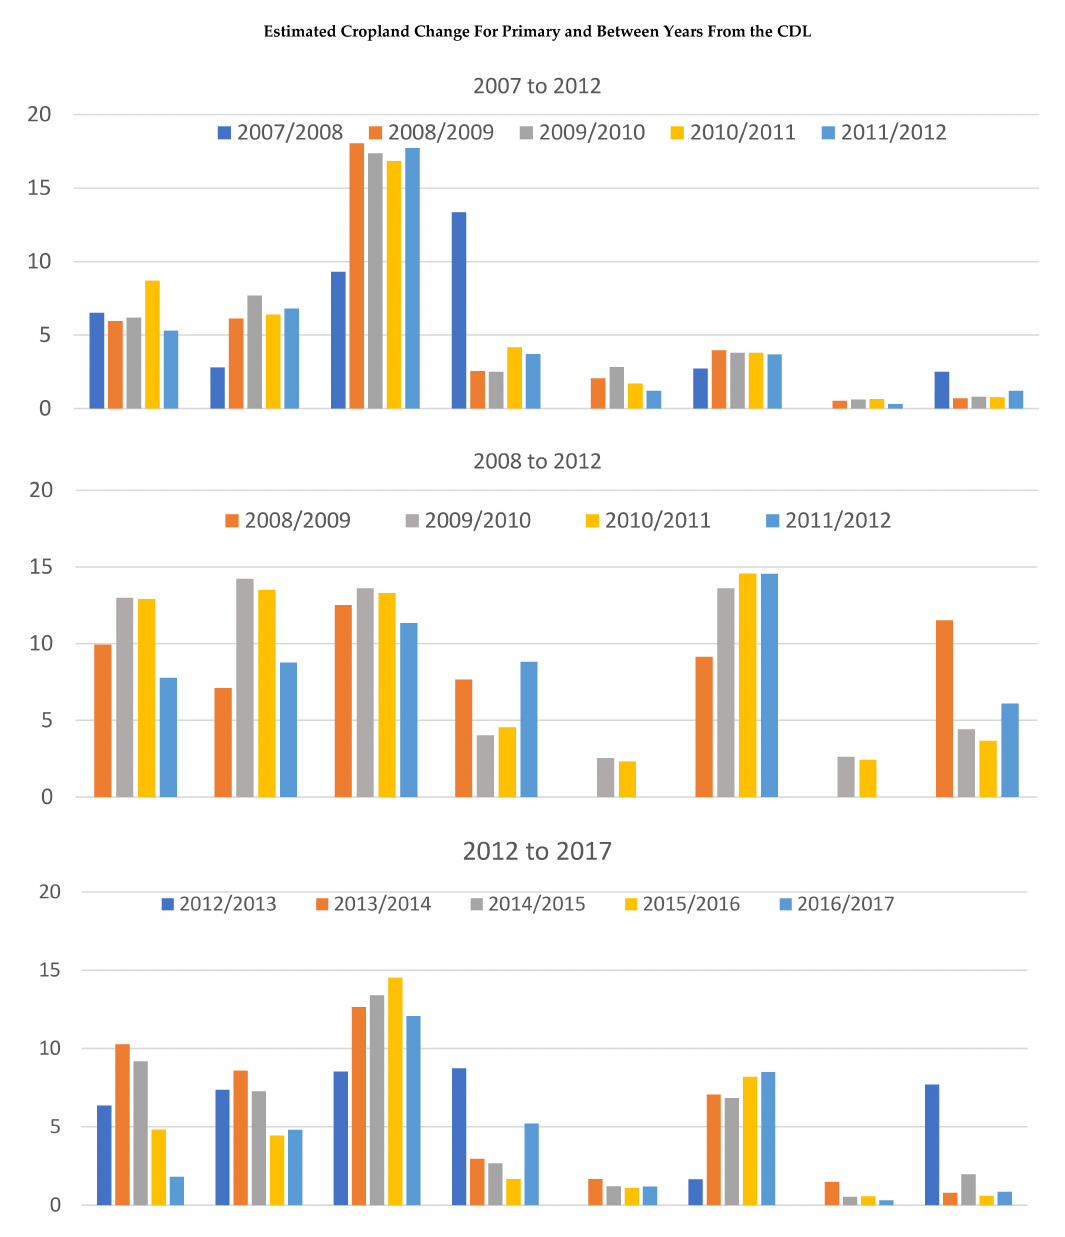
Figure 9. In millions of hectares, change to and from cropland from a comparison of CDLs with a 4 to 5year time-span and for year-to-year